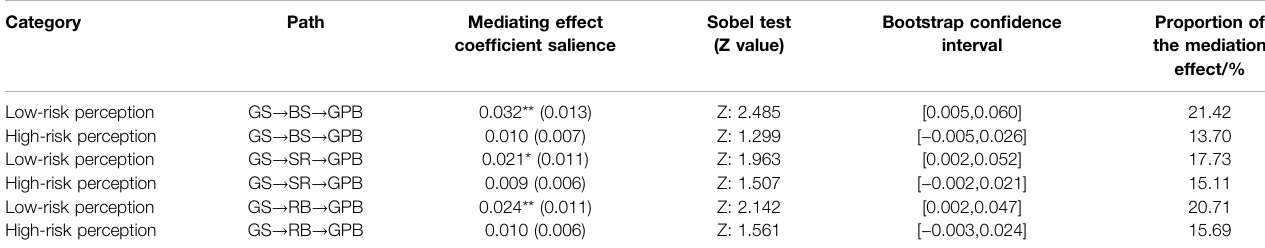
TABLE 4 | Subsample mediation effect test of government